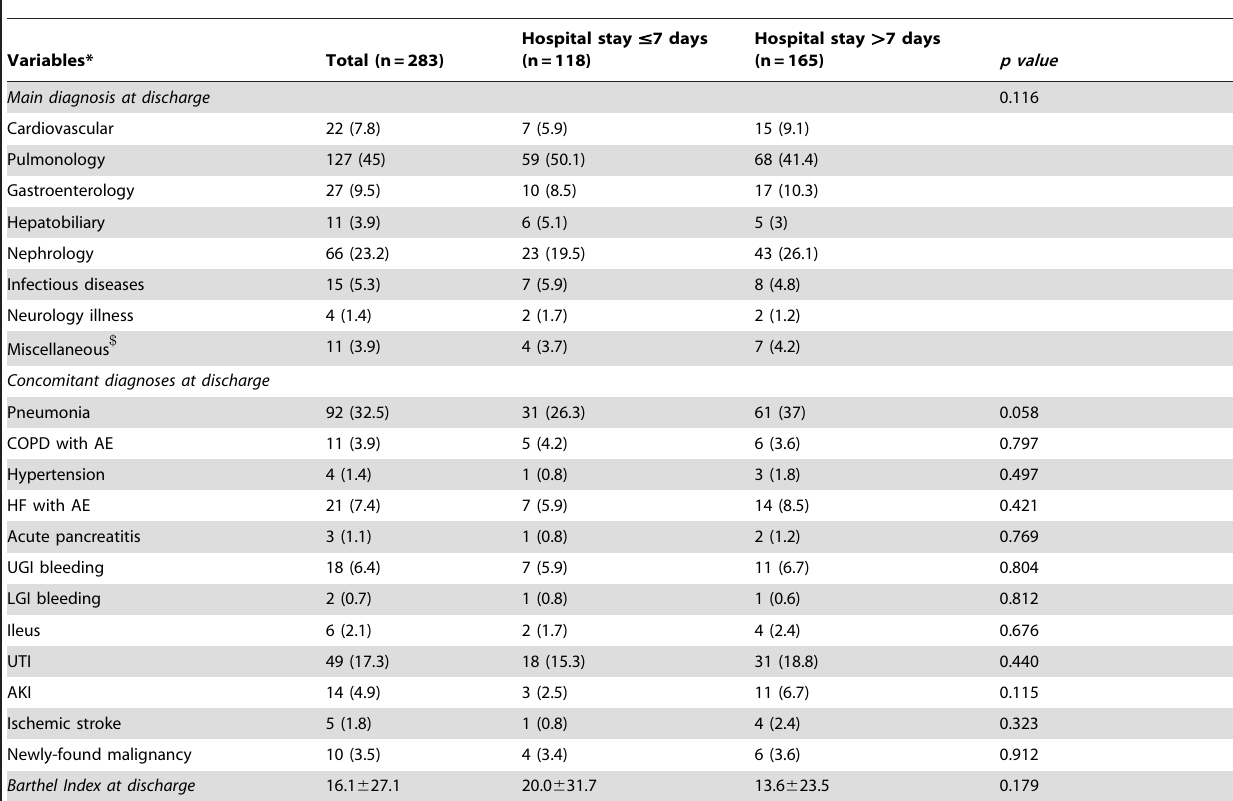
Table 3. Discharge diagnoses of admitted nonagenarians by hospital length of stay (percentage in parentheses).